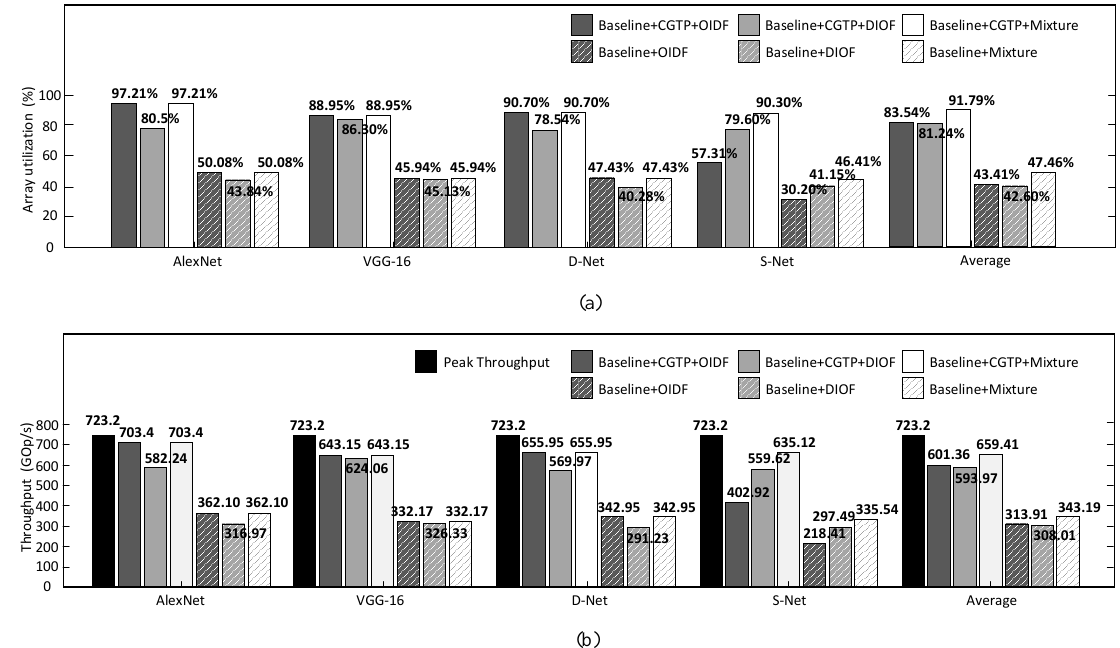
Figure 12. Combined performance of the proposed CGTP strategy and different dataflows, ( a ) array utilization, ( b )